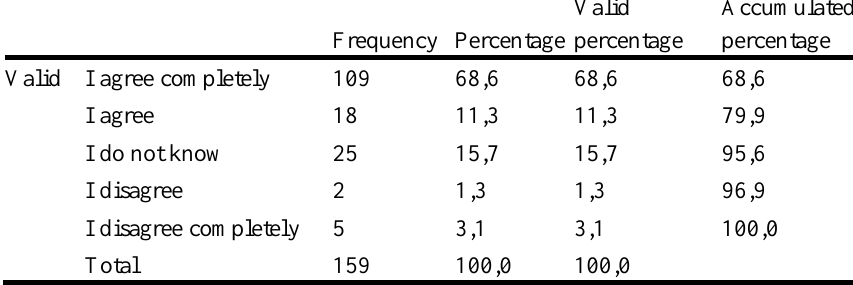
Valid percentage questionnaires´ results, question